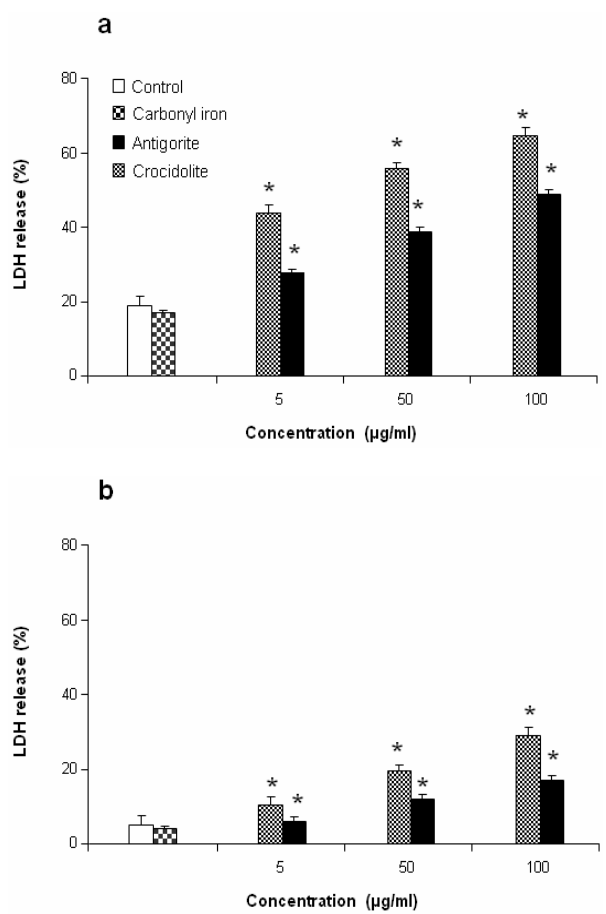
Figure 6: Lactate dehydrogenase (LDH) release from the MeT-5A (a) and J774 (b) cells expressed as percentage of LDH released into the cell medium with respect to total LDH. The values are the mean ± SEM of three experiments performed in triplicate. All values with P <0.01 were considered significantly different from control values and marked with an